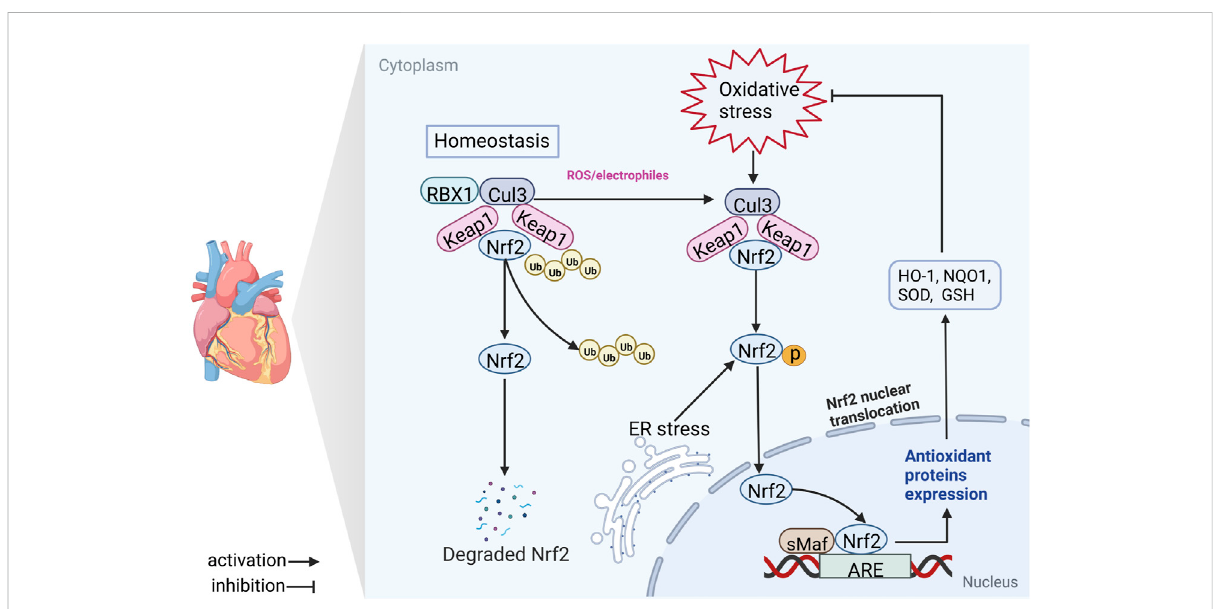
FIGURE 1 Schematic diagram of the Nrf2/ARE signaling axis. In the majority of conditions, Keap1 binds the Cul3 E3 ligase, forming a Keap1-Cul3- RBX1 E3 ligase complex, which promotes ubiquitination and degradation of Nrf2. Nrf2 is cleaved from the Keap1-Cul3-RBX1 complex and translocases to the nucleus where it heterodimerizes with sMaf and binds ARE in response to antioxidant stress (electrophilic, ROS or ER stress) damage. Nrf2,nuclear factorerythroid 2-related factor2;Keap1,Kelch-likeECH-associated protein1;RBX1, RING-box protein1;Ub, ubiquitin; Cul3, cullin 3; ER stress, endoplasmic reticulum stress; sMaf, small musculoaponeurotic fi brosarcoma; ARE, antioxidant response element; GSH, glutathione; NQO1, NADPH quinone oxidoreductase 1; SOD, superoxide dismutase; HO-1, heme oxygenase